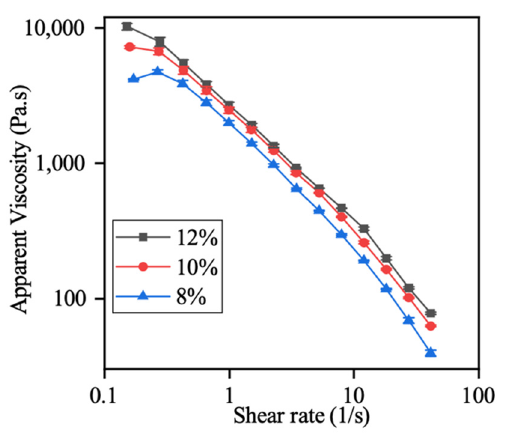
Figure 2. Apparent viscosity versus shear rate profiles of carboxymethyl cellulose (CMC) at different concentrations (8%, 10%, 12% w / w ). Values are presented as the mean ± SD ( n = 3).